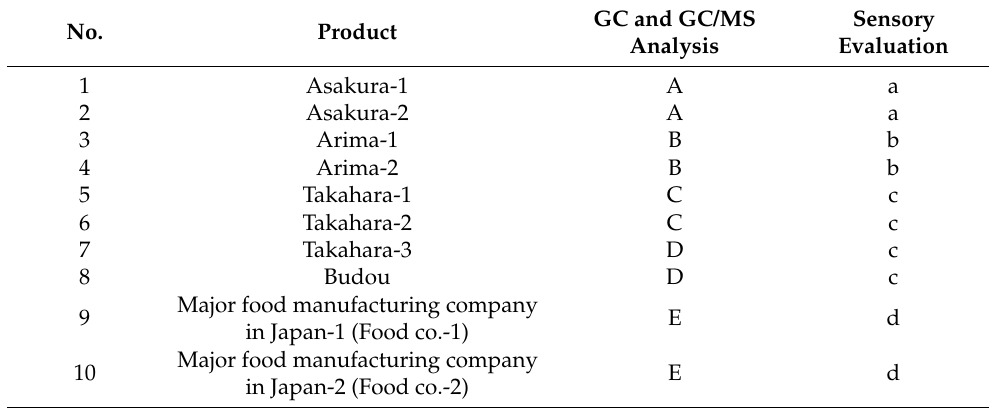
GC and GC/MS Analysis